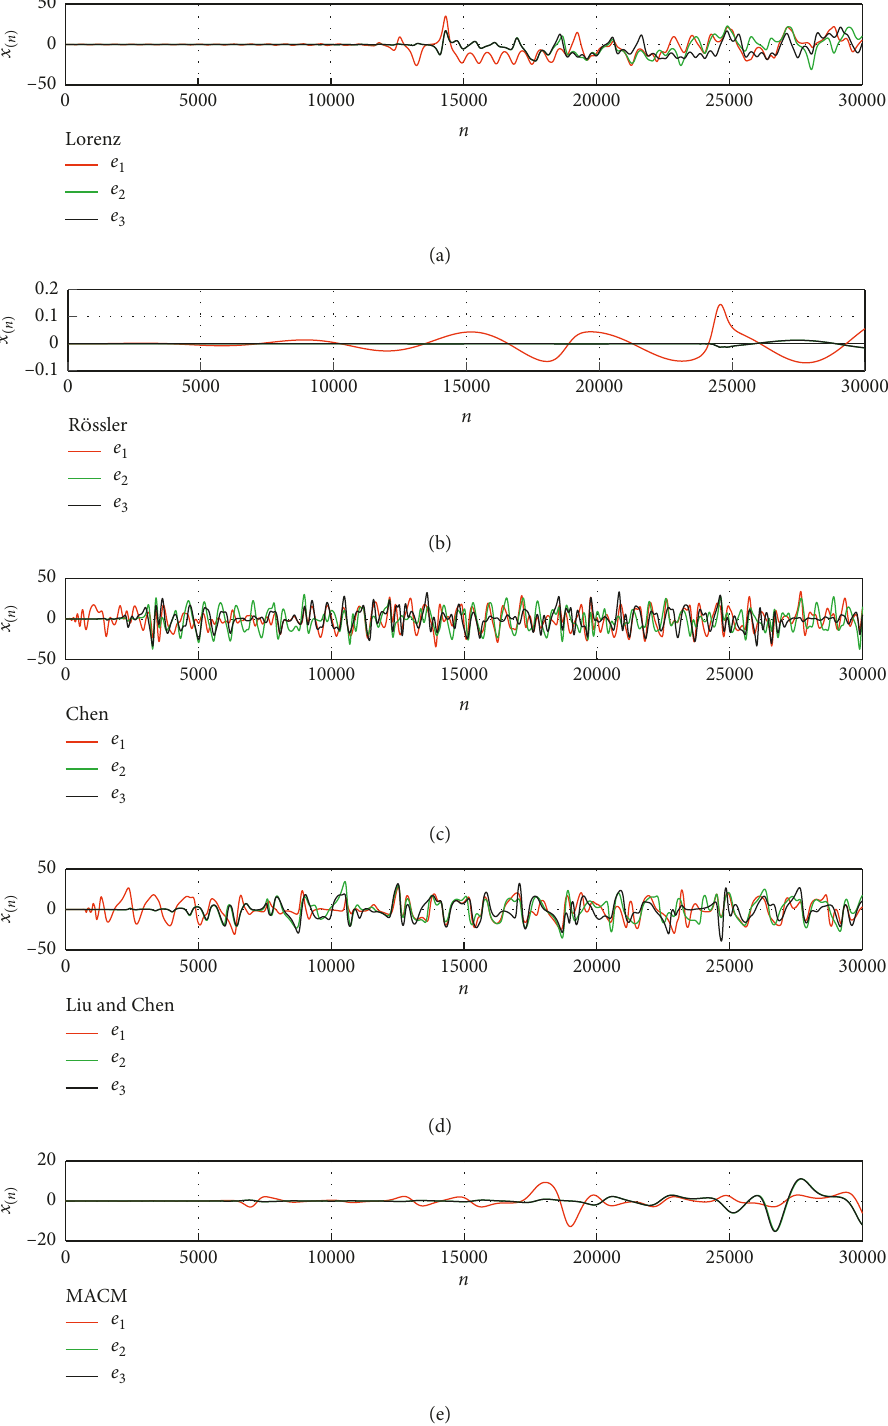
Figure 3: Errors e 1 , e 2 , and e 3 shown in Figure 2 for the CSs: (a) Lorenz (1), (b) R¨ossler (2), (c) Chen (3), (d) Liu and Chen (4), and (e) MACM